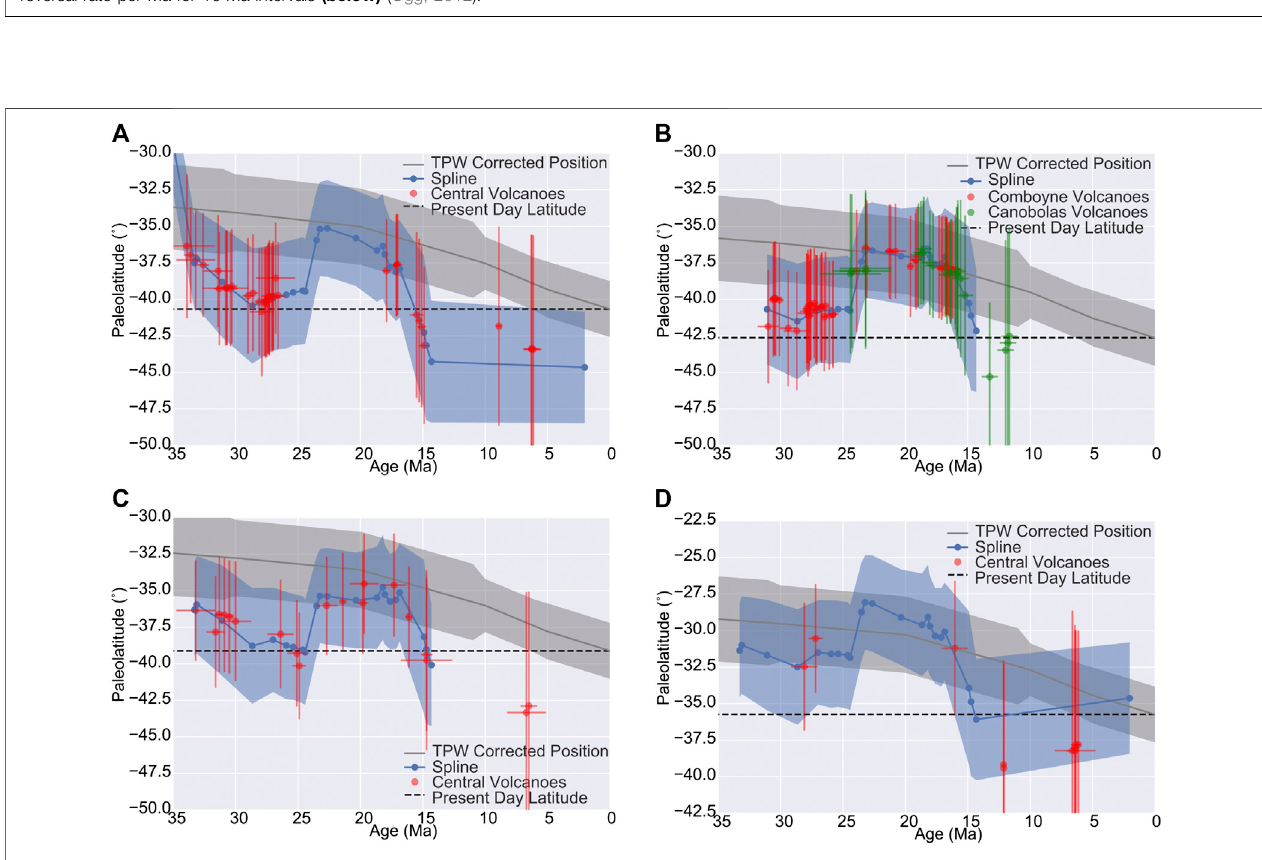
FIGURE 11 | Paleolatitudes for the (A) Cosgrove, (B) Comboyne, Canobolas, (C) Tasmantid, and (D) Lord Howe hotspots. Red (and green) data indicate paleolatitudeofvolcanicrocklocalitieswithgeochronologicconstraint(with2 σ ageerrors,and95%con fi denceonpaleolatitudes)alongeachhotspottrack.Theblueline represents paleolatitudes for spline fi ts with shaded 95% con fi dence region. Tabulated values are given in Supplementary Material . The black dashed line is a fi xed point, in thepaleomagnetic reference frame, at the present day position ofeach hotspot. The gray line istheTPW corrected position ofthis point through time (that is, fi xed in the mantle reference frame) with associated shaded 95% con fi dence limits (Doubrovine et al., 2012; Torsvik et al., 2012).